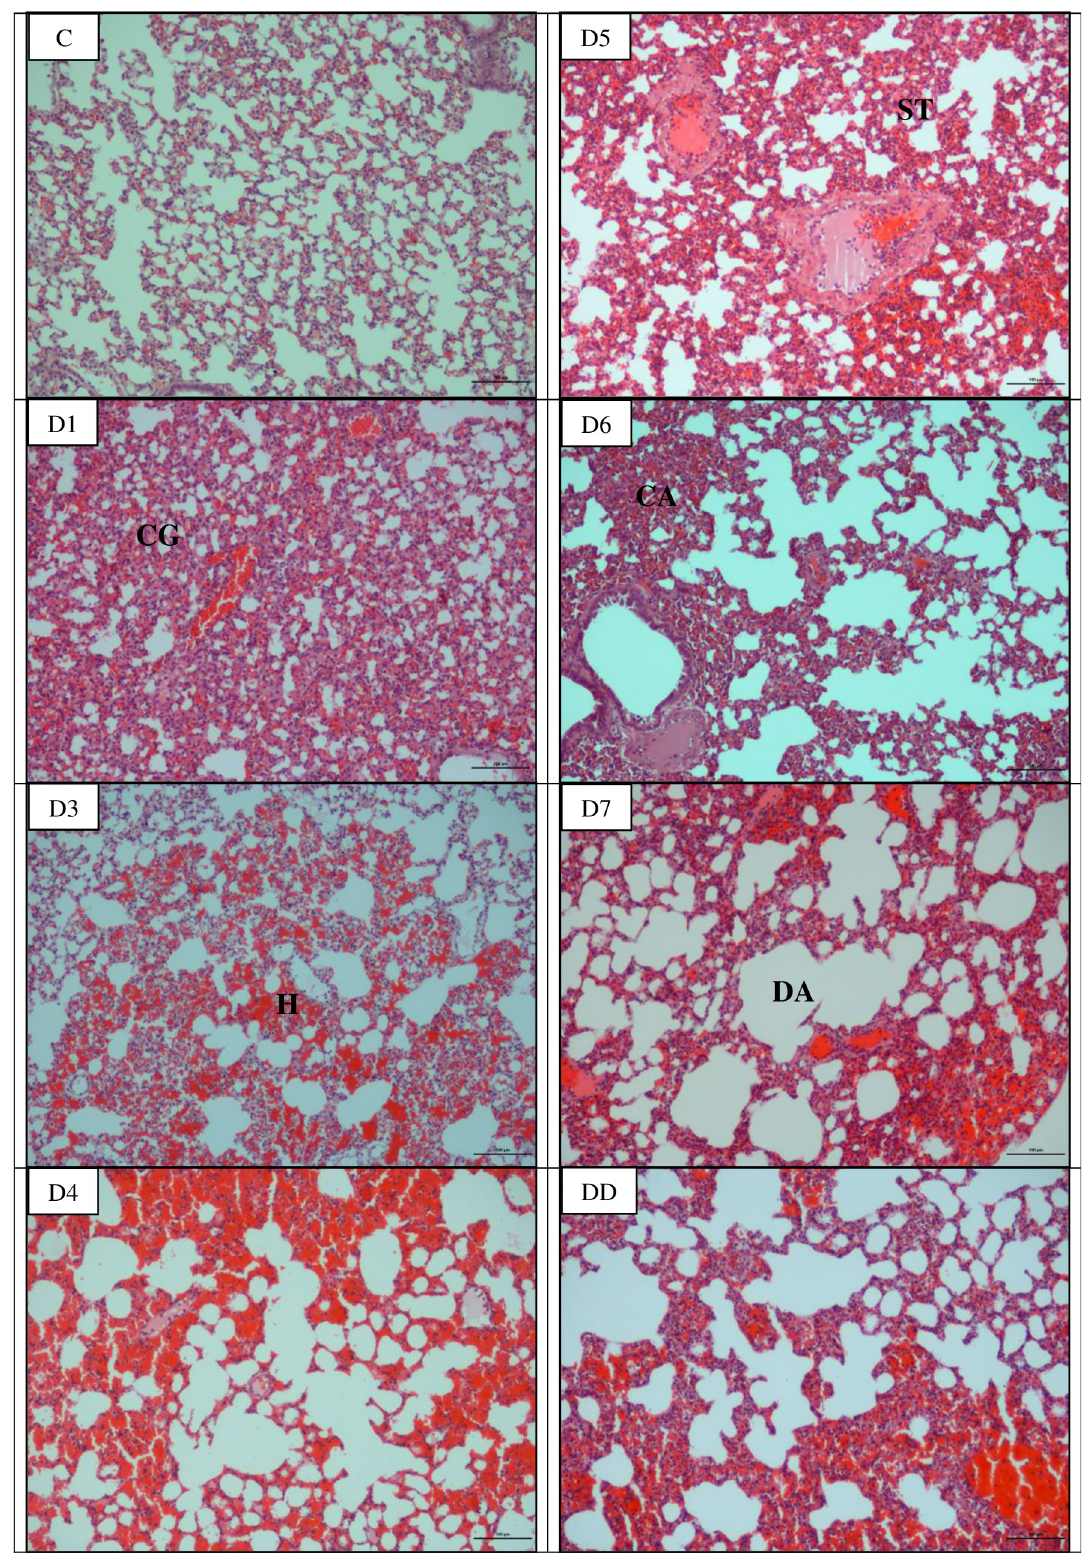
Fig 3. Histopathological lesions in the lung of infected hamsters. Congestion and haemorrhage occurred as early as day 1 p.i. while dilated and collapsed alveoli occurred on days 6 and 7 p.i. and in dead hamsters. CG: Congestion, H: Haemorrhage, CA: Collapsed alveoli, ST: Septal thickening, DA: Dilated alveoli. C: Control, D1-D7: Day 1- day 7 and DD: Dead. Magnification: x100, bar: 100 μ m. https://doi.org/10.1371/journal.pntd.0010409.g003 PLOS NeglectedTropical Diseases | https://doi.org/10.1371/journal.pntd.0010409 May 18,